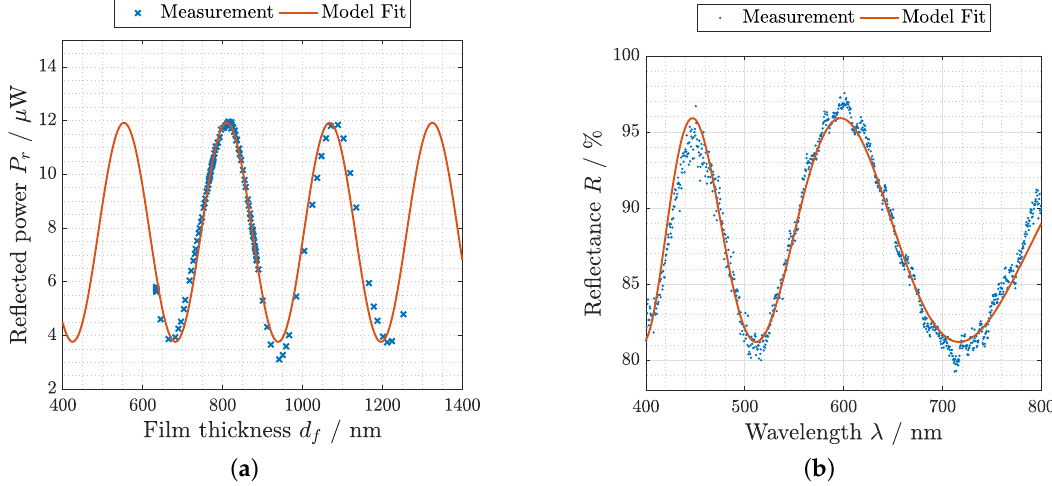
Figure 3. Measurements with corresponding model fit for ( a ) the laser interference setup for a wavelength of 635nm at an incident angle of 60.5 ◦ , which shows the reflected power over the thin-film thickness derived by spectral reflectance measurements such as the one shown in ( b ) for an exemplary thickness value of ( 644.8 ± 0.8 ) nm at an incident angle of 37 ◦ . Note: All reflectance spectra are related to a reference measurement with a sapphire substrate without hydrogel